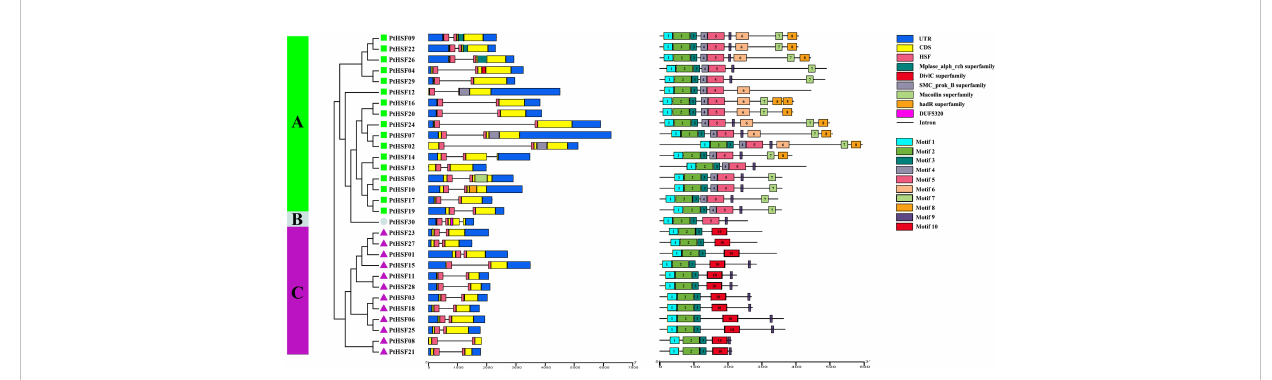
FIGURE 3 Analysis of HSF gene structure and conserved motif of poplar. The phylogenetic tree was constructed based on 30 HSF protein sequences from poplar, which were divided into three subfamilies. In the gene structure analysis, blue represents the UTR, yellow represents the CDS, pink represents the HSF region, and “–” represents the intron. The conservative motif of the HSF gene is predicted by the MEME website. The number in the color block (1 – 10) represents motifs 1 – 10, respectively, and the length of the color block indicates the size of the motif.